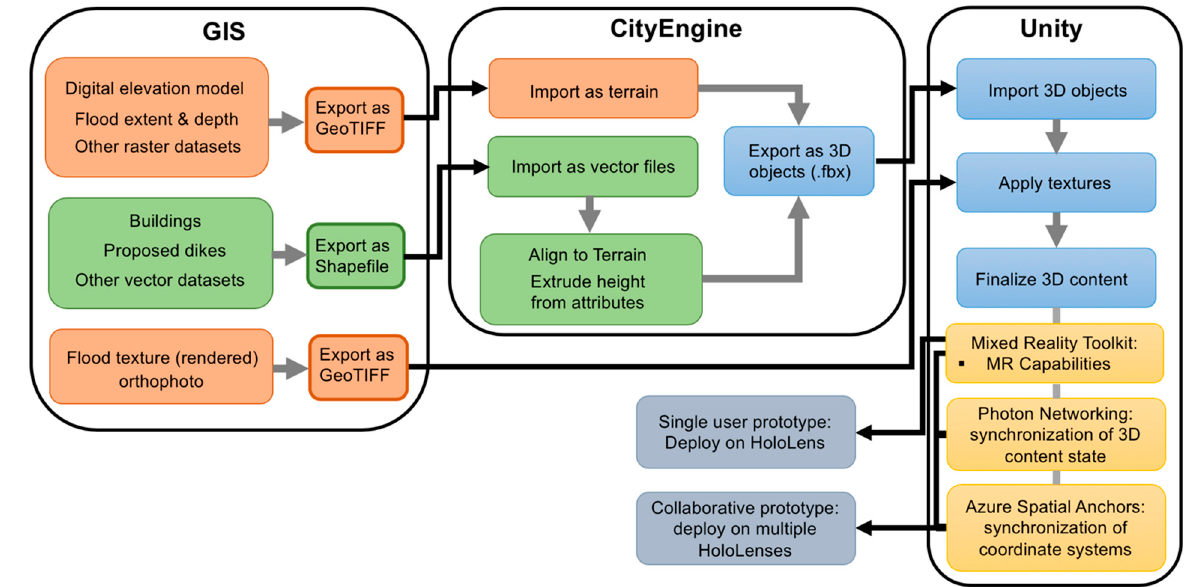
Figure 1. This flowchart presents an overview of the development workflow from conventional GIS data (orange boxes representing raster data, green boxes representing vector data) that is exported in appropriate format and converted to 3D geometry (blue boxes) in CityEngine, created 3D model can then be imported into Unity and integrated with various mixed reality toolkit components (yellow boxes) to create single and shared user applications deployed on HoloLens 2.